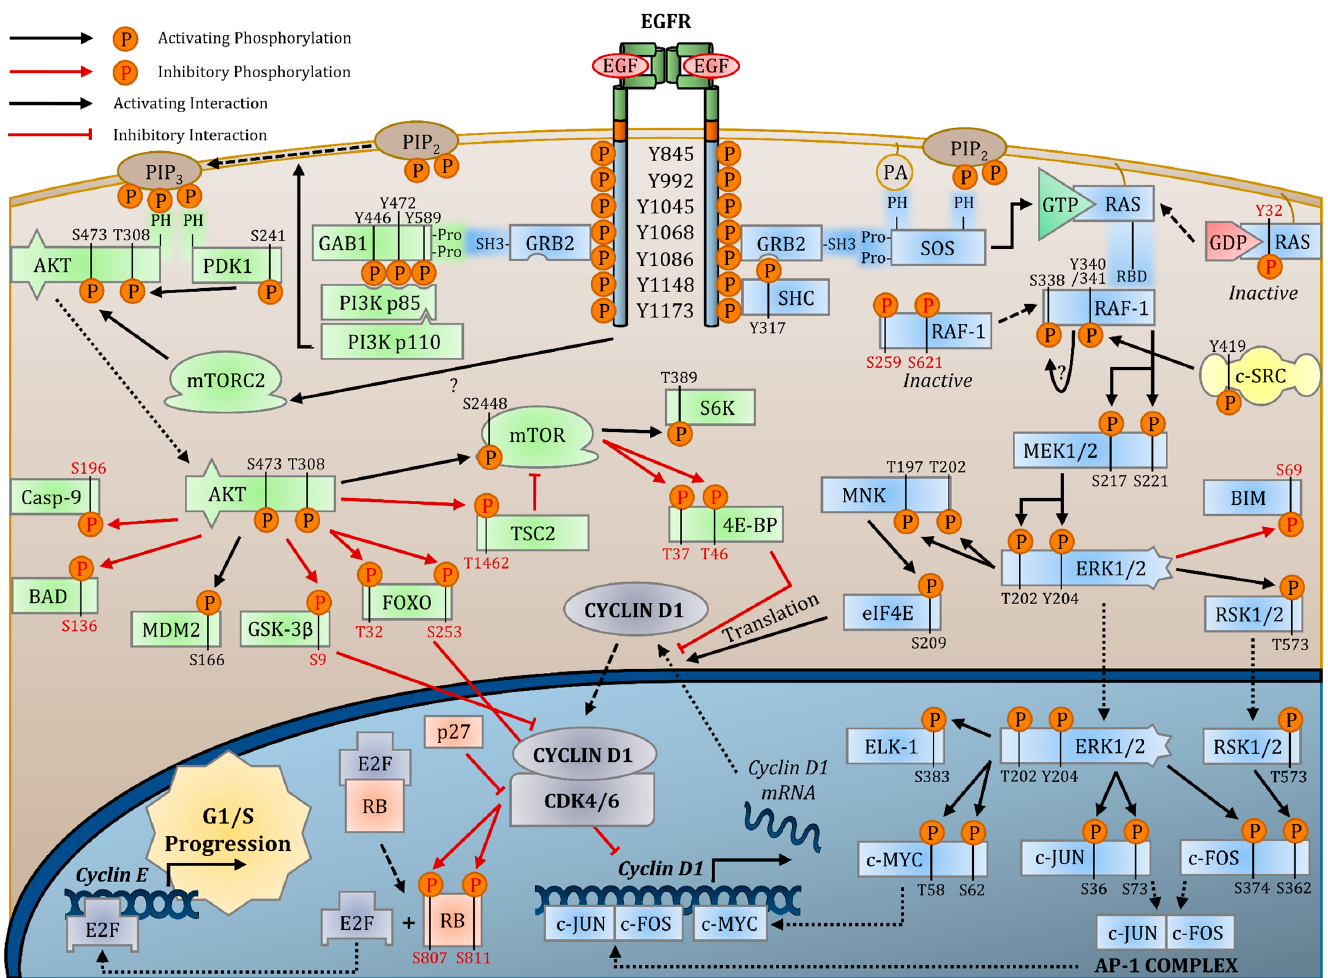
Figure 1. Epidermal growth factor receptor (EGFR) signaling pathways leading to G1/S cell cycle progression activated by EGF activation. Depicted are the RAS-RAF-MEK-ERK MAPK and PI3K-AKT-mTOR pathways. EGF activation of the EGFR induces receptor dimerization and transphosphorylation of the